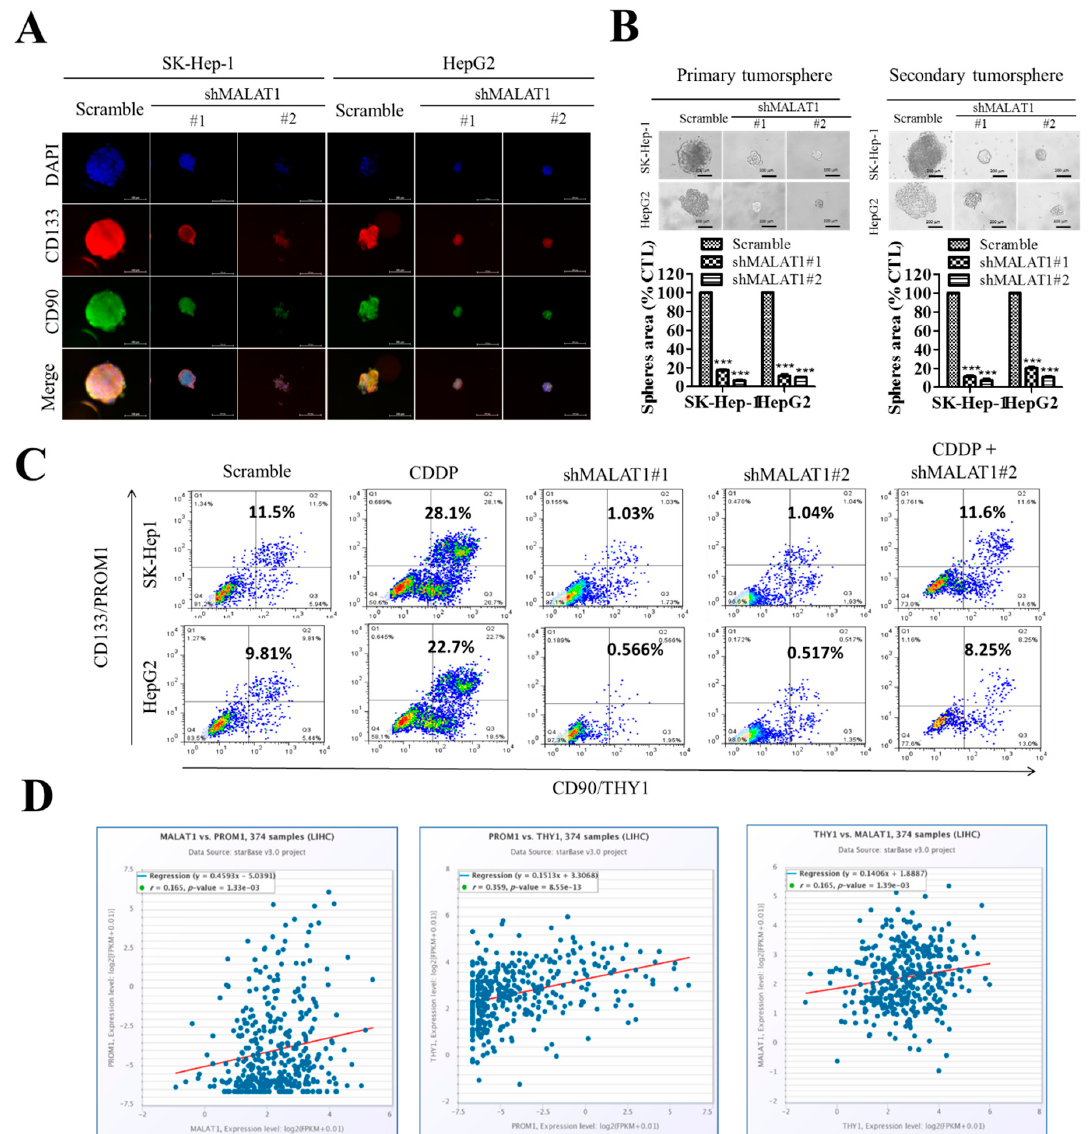
Figure 5. Silencing MALAT1 is associated with reduced CD133 high CD90 high HCC population with suppressed HCC tumorsphere formation in vitro. ( A ) Photo-images showing the effect of shMALAT1#1 and shMALAT1#2 on the size of tumorspheres formed and on the expression of CD133 and CD90 (left panel). Histograms show the effect of shMALAT1 #1 and #2 on number of tumorspheres formed (right panel). ( B ) SK-Hep1 or HepG2 cells transfected with shMALAT1#1 and shMALAT1#2 exhibited decreased HCC tumorsphere size and number in both primary and secondary generation tumorsphere. ( C ) Comparative flow-cytometry analysis CD133 and CD90 positivity in SK-Hep1 or HepG2 cells exposed to CDDP or transfected with shMALAT1#1 and shMALAT1#2. ( D ) Graphical representation of the correlation between MALAT1, CD133, and CD90. CDDP, cisplatin; *** p < 0.001.